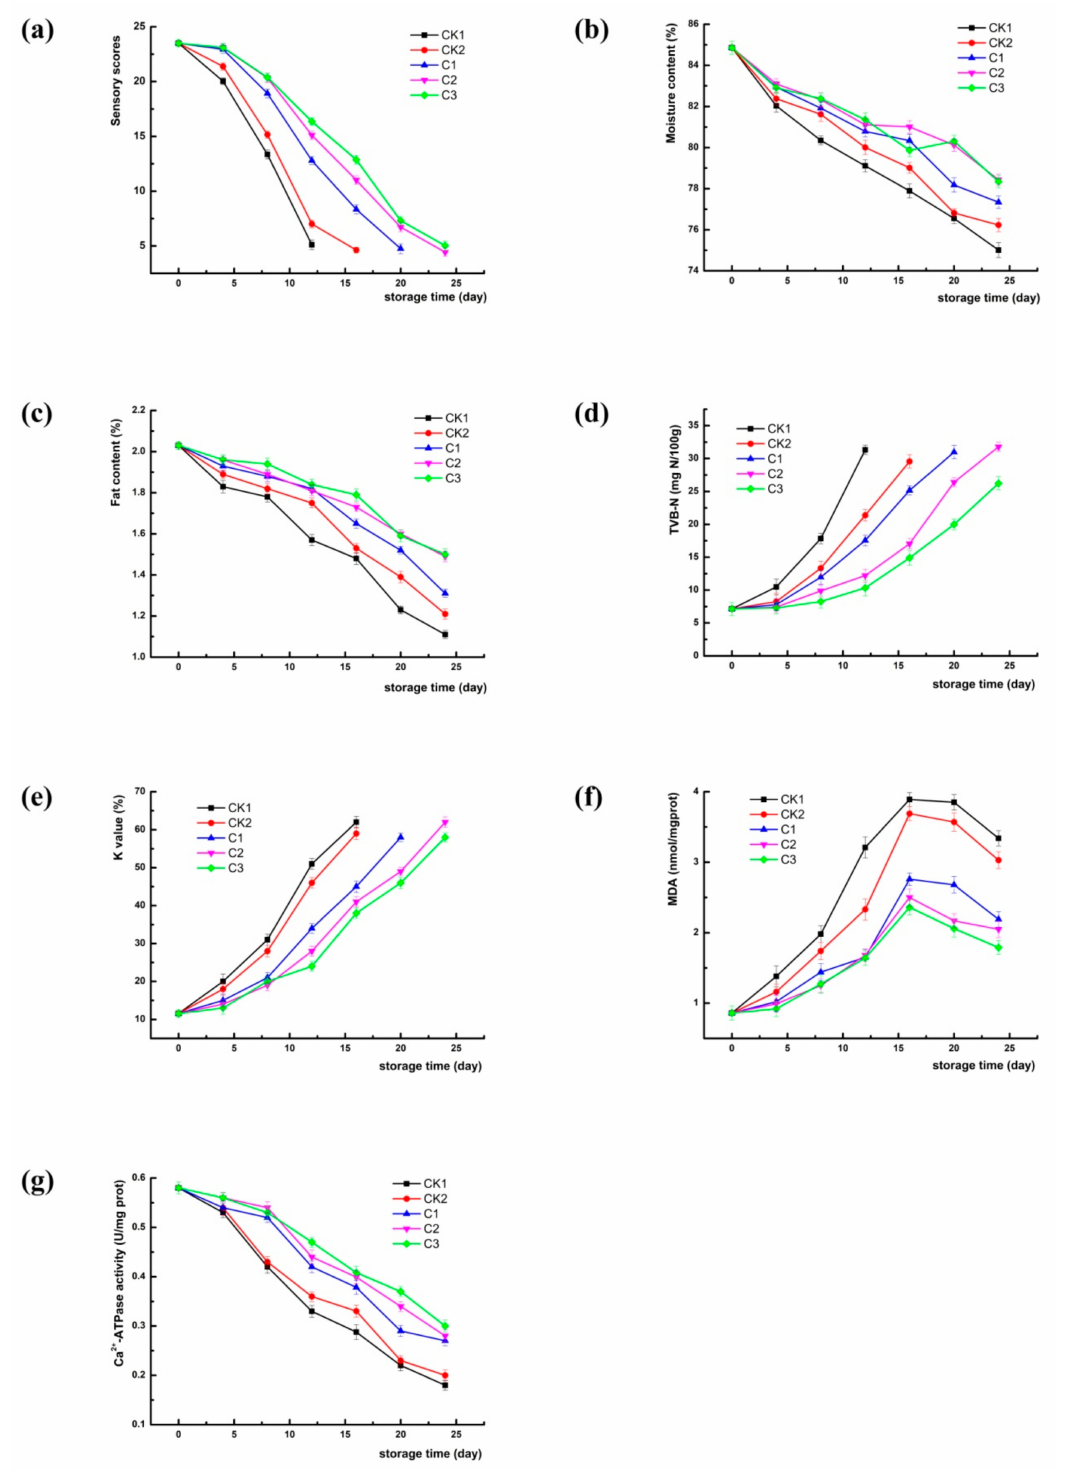
Figure 1. Changes in sensory scores ( a ), moisture content ( b ), fat content ( c ), and TVB-N value ( d ), K value ( e ), MDA ( f ) and activity of Ca 2 +-ATPase ( g ) of samples during refrigerated storage (CK1: distilled water + air packing; CK2: edible coating + air packing; C1: edible coating + MAP (60% CO 2 /40% N 2 ); C2: edible coating + MAP (65% CO 2 /35% N 2 ); C3: edible coating + MAP (70% CO 2 /30% N 2